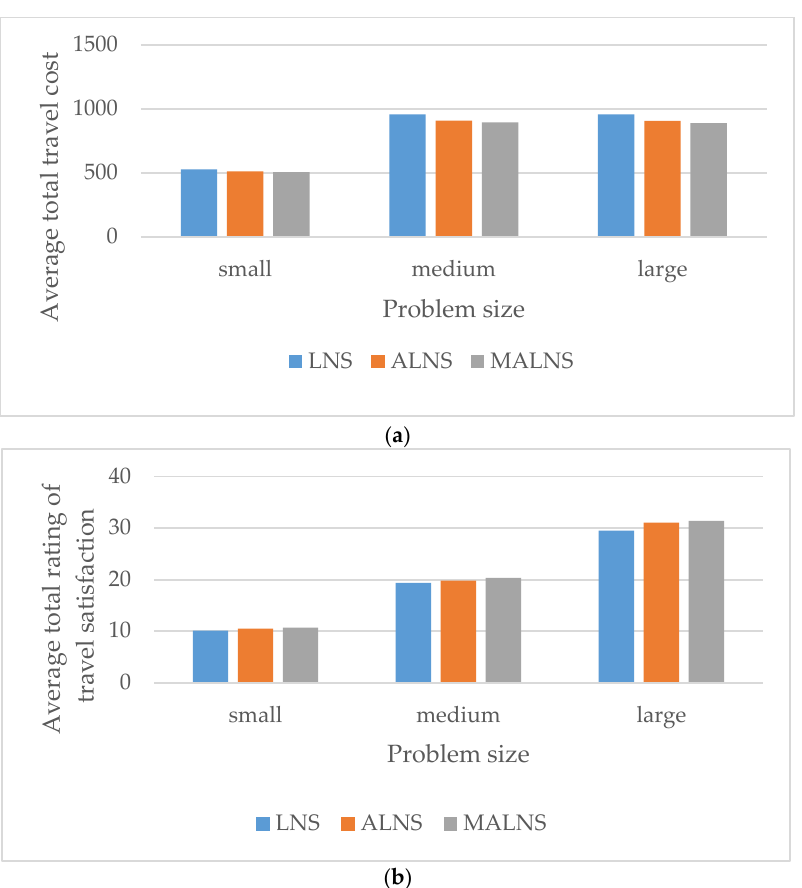
Figure 10. Tentative comparison of the solution of the algorithms ( a )Average total travel cost com- parison of each problem size. and ( b ) Average total rating of travel satisfaction of each problem size.